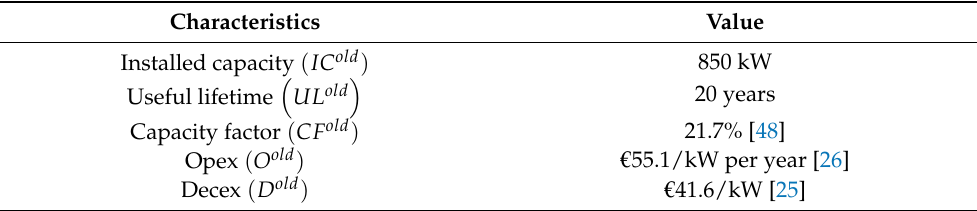
Table 6. Case 1—Characteristics of the old turbines installed (Gamesa G-58/850). Characteristics Value Installed capacity ( IC old ) 850 kW (cid:16) UL old Useful lifetime